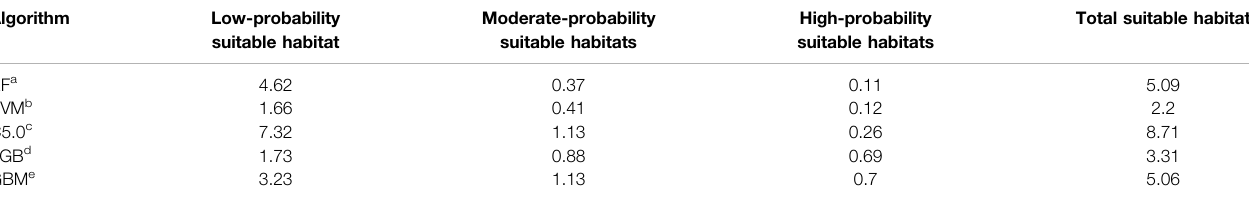
TABLE 3 | Proportion of the predicted by low-, moderate-, and high-probability suitable habitats by fi ve algorithms in total suitable habitats in Suzhou City (%). Algorithm Low-probability Moderate-probability High-probability Total suitable suitable habitat suitable habitats suitable habitats